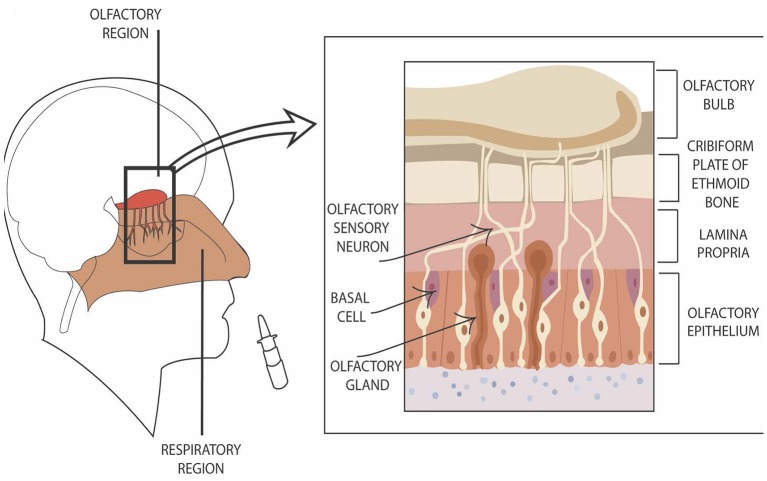
Graphic presentation of direct nose-to–brain entry. The left side of the figure shows the location of nasal olfactory region. The right side of the figure depicts the location of olfactory sensory neurons in reference to additional cell types in the region.